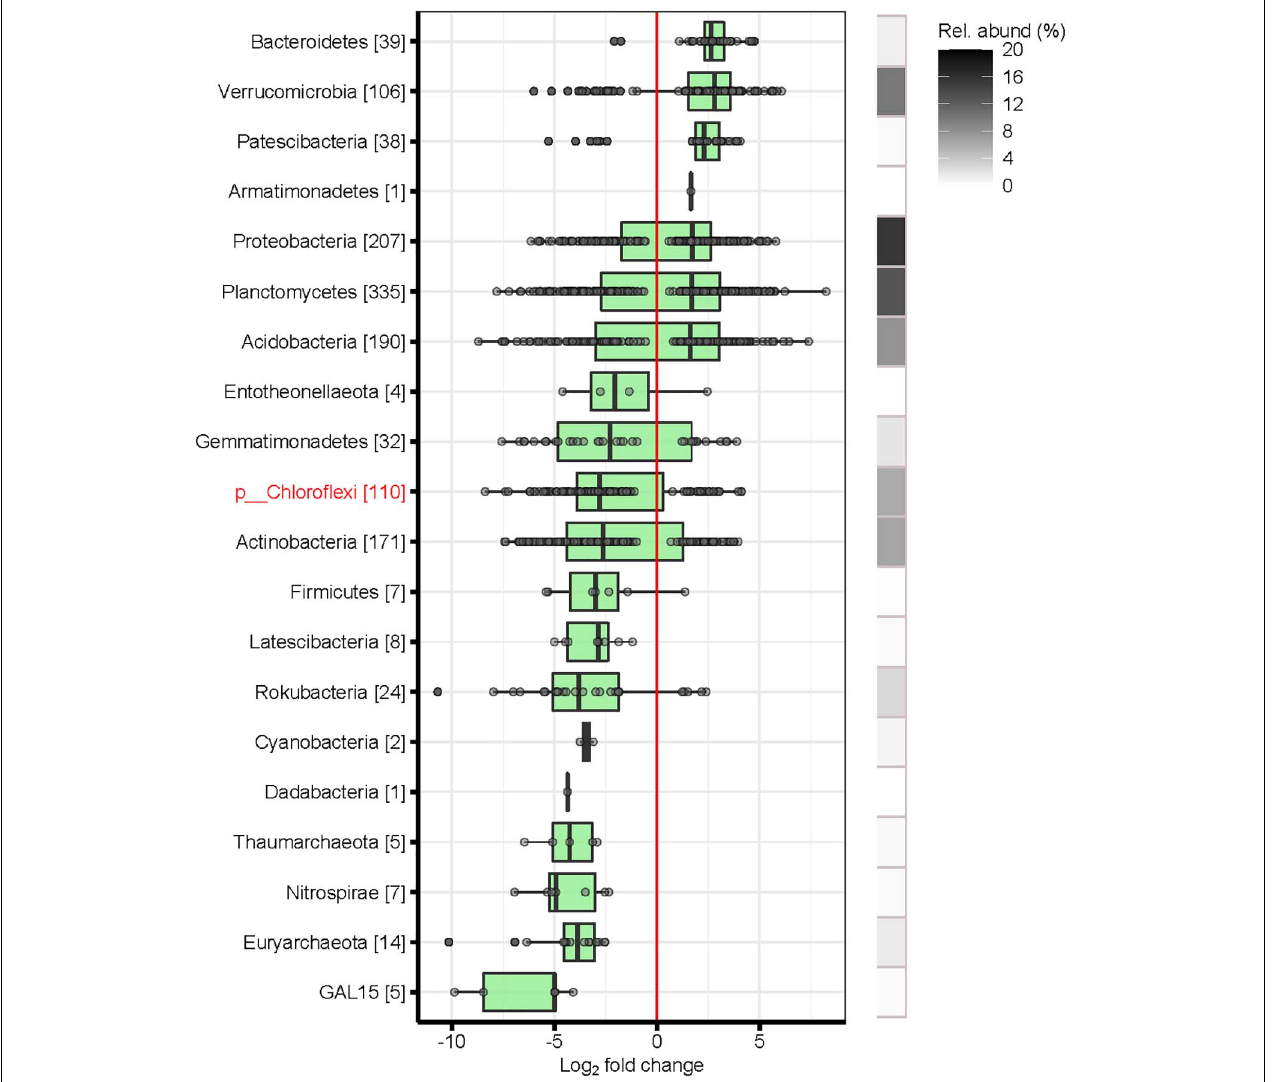
FIGURE 4 | Differentially abundant bacteria phyla of topsoil (soil layers L1 and L2) vs. subsoil (soil layers L5 and L6). Shown are only significant log 2 -fold changes (LFC) of phyla based on a significance level of p < 0.01 after false discovery rate correction. Error bars represent standard deviation. Positive LFC values indicate a higher occurrence of phyla in the topsoil, whereas negative LFC indicate a higher occurrence in the subsoil. The number of differentially abundant OTUs comprised in each phyla are indicated in brackets. Poorly known phyla are highlighted in red. Relative abundance (%): sum of the abundance of the differentially abundant OTUs belonging to the same phyla as a percentage of the total number of sequences across the compared soils. Soil layers: L1: 0–10 cm, L2: 15–25 cm, L5: 110–125 cm, L6: 140–155